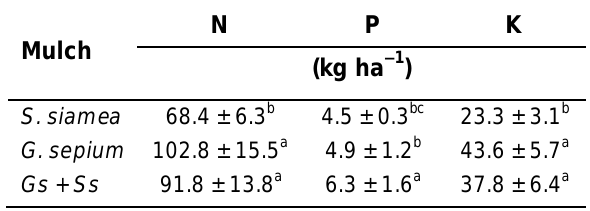
Values are means of three replicates ± S.E. Means in the same column followed by different letters are significantly different at p < 0.05 according to Duncan’s multiple range test. Gs + Ss , Gliricidia sepium and S. siamea mixed